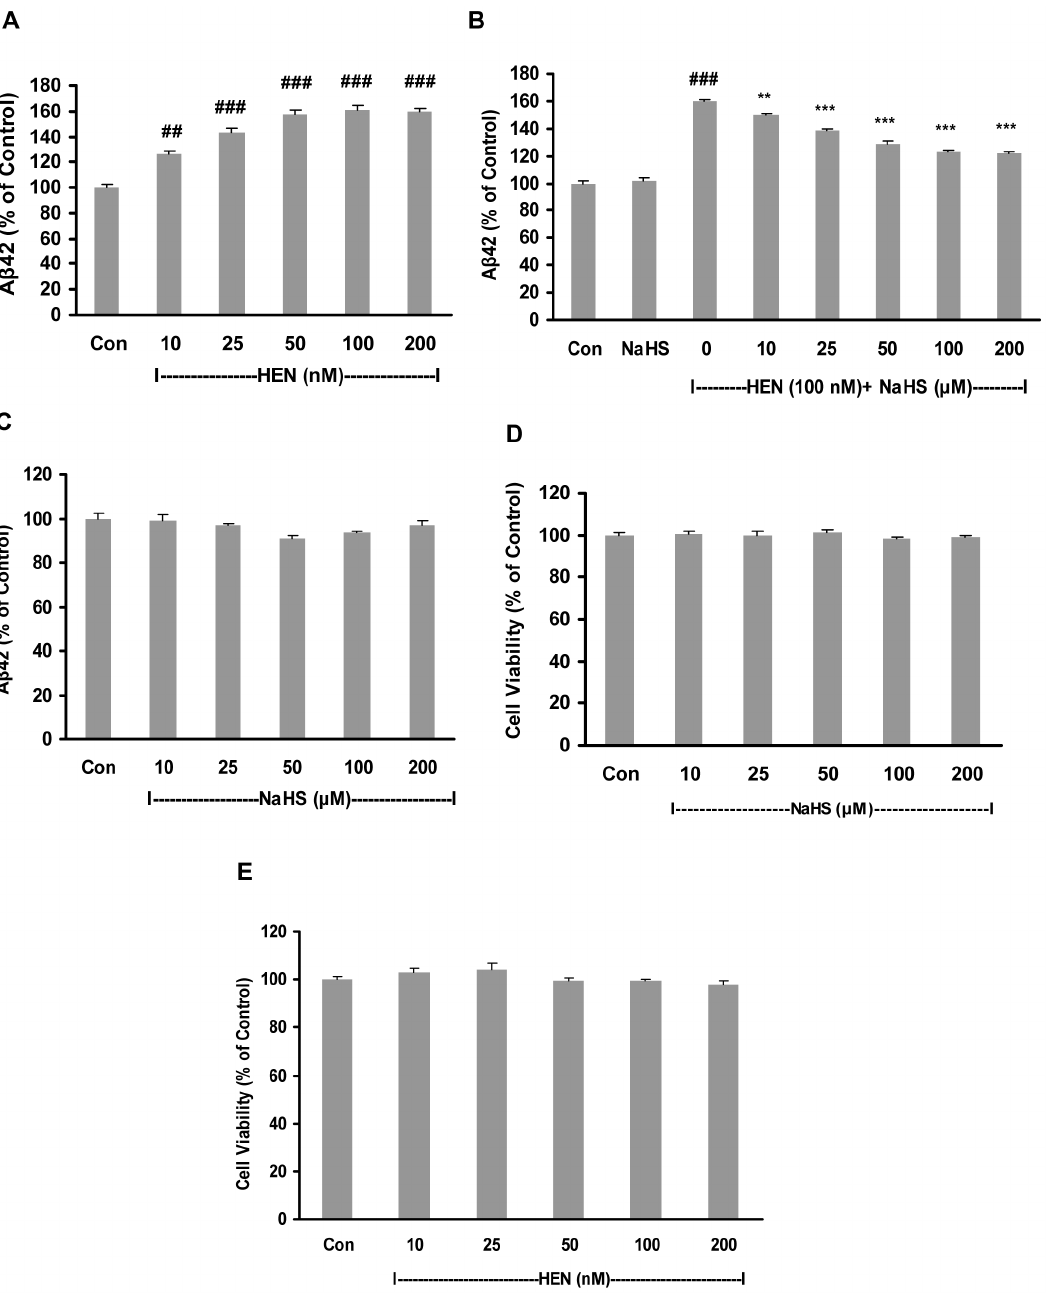
Figure 1. Effect of NaHS on A b 42 production and cell viability in SH-SY5Y cells expressing APPswe. A : Concentration-dependent effect of HENECA (10–200 nM, 24 hours) on A b 42 production. B–C : Dose-dependent effect of NaHS (10–200 m M, 12 hours) on A b 42 formation in the presence (B) and absence (C) of HENECA (100 nM, 24 hours). D–E : MTT assay showing the effect of NaHS alone at 10–200 m M (D) or HENECA alone at 10–200 nM (E) on cell viability of SH-SY5Y cells. A b 42 levels in conditioned media were measured by sandwich ELISA kit. Control values were adjusted to 100%. Data are given as means 6 S.E.M, n=6. ## p , 0.01, ### p , 0.001 vs Con group; ** p , 0.01, *** p , 0.001 vs HEN group. Con, control; HEN,